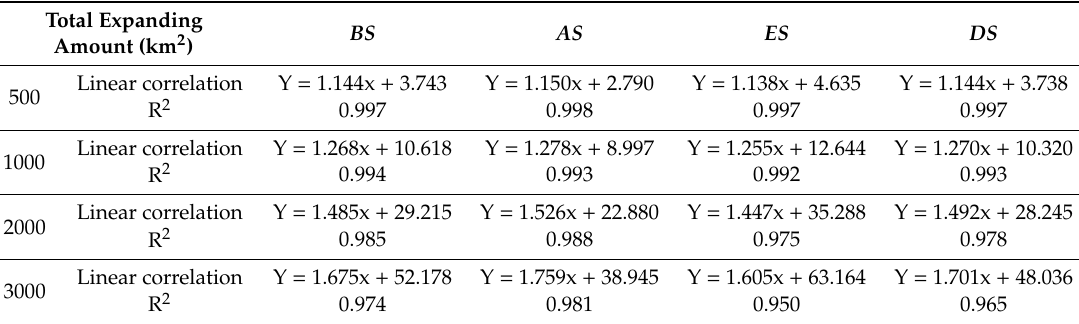
Table 4. Correlation coe ffi cient of urban sizes and their existing areas under four